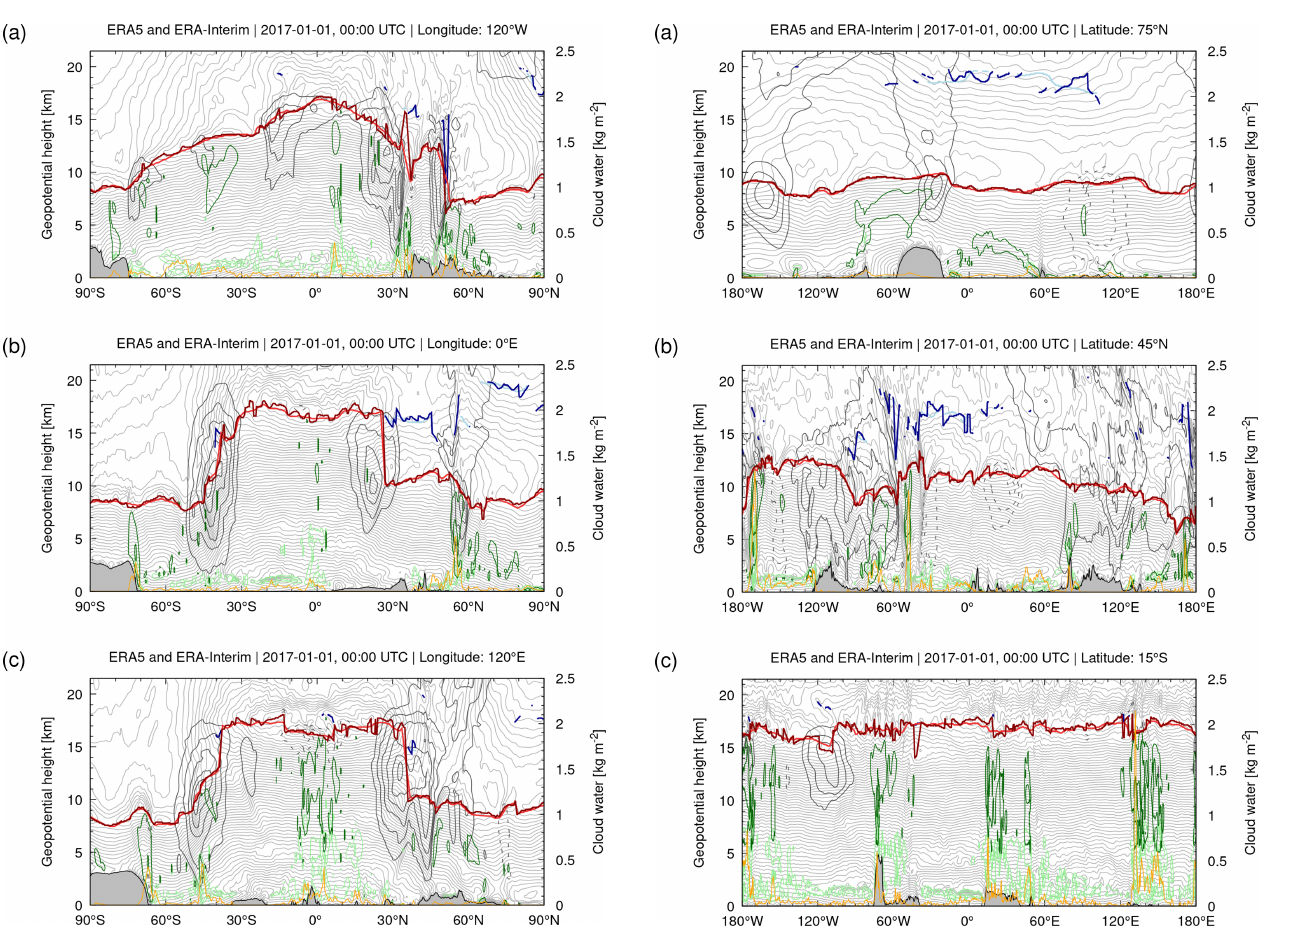
Figure 4. Same as Fig. 3 but for zonal cross sections at (a) 75 ◦ N, (b) 45 ◦ N, and (c) 15 ◦ S. The cross sections were sampled at 0.3 ◦ in longitude and 150m in